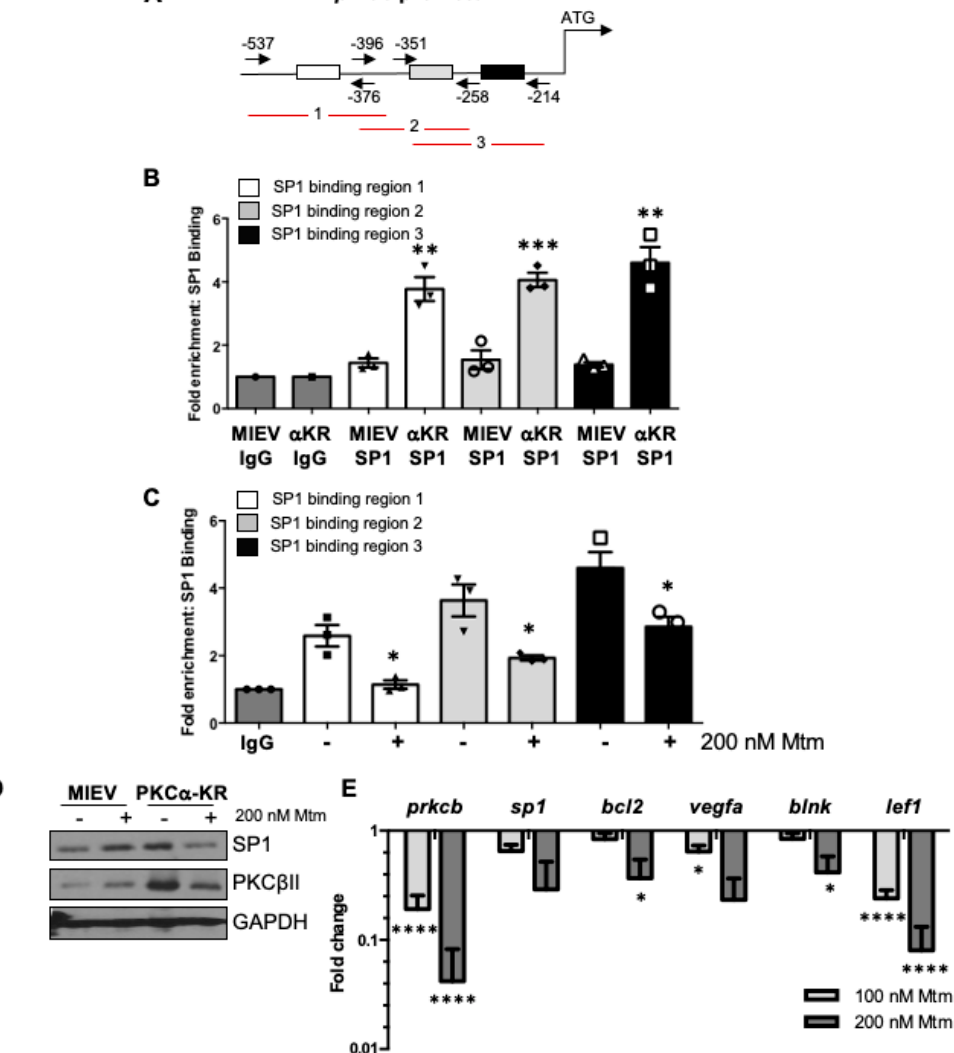
Figure 2. Sp1 binding is upregulated in the prkcb promoter of PKC α -KR transduced CLL-like cells. ( A ) Diagram showing Sp1 binding sites at the prkcb promoter, the primer locations and the three products; ( B ) ChIP analysis was performed in MIEV (binding region 1 (black triangles), 2 (white circles), 3 (white triangles)) and PKC α -KR cells (binding region 1 (inverted triangles), 2 (diamonds), 3 (squares)) at the late stage of co-culture (> d17) to determine Sp1 binding occupancy at the prkcb promoter (average of n = 3 biological replicates); ( C ) ChIP analysis was performed in PKC α -KR cells in the absence (binding region 1 (black squares), 2 (inverted triangles), 3 (white squares)) and presence of 200 nM mithramycin (mtm; binding region 1 (triangles), 2 (diamonds), 3 (circles)) for 12 h to determine Sp1 binding at the prkcb promoter (average of n = 3 biological replicates); ( D ) The